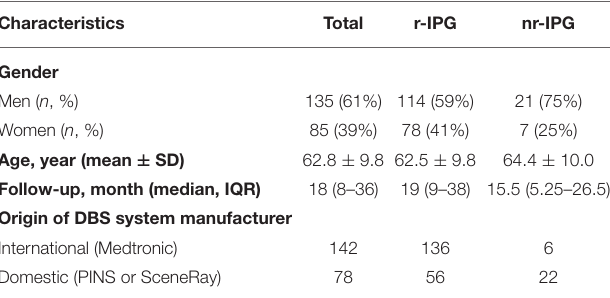
TABLE 1 | Patient sample characteristics ( N =